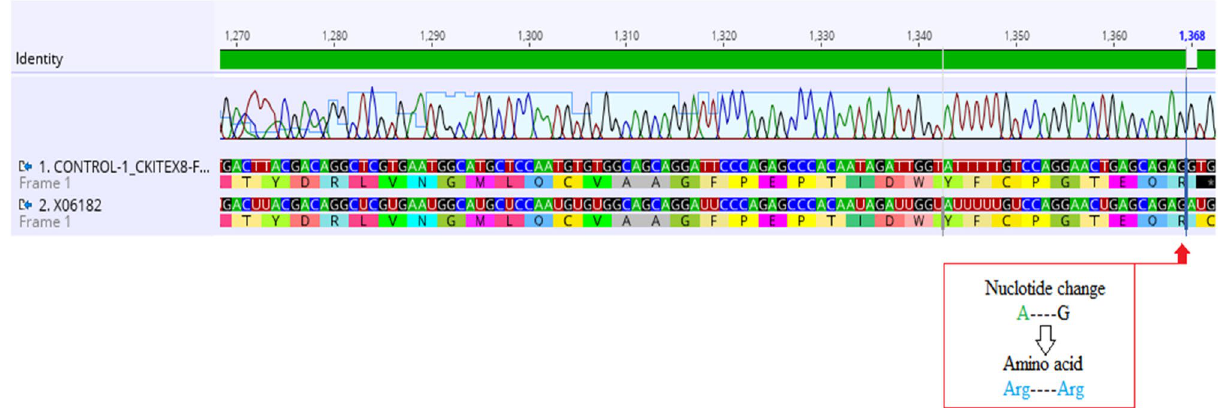
Figure 1. Electropherogram showing nucleotide change (A → G) in Control (healthy person) at position 1368 in c-kit exon 8. However resulting amino acid after this change remains the same as in the reference sequence (GenBank: X06182), which indicates discrepant site in c-kit exon